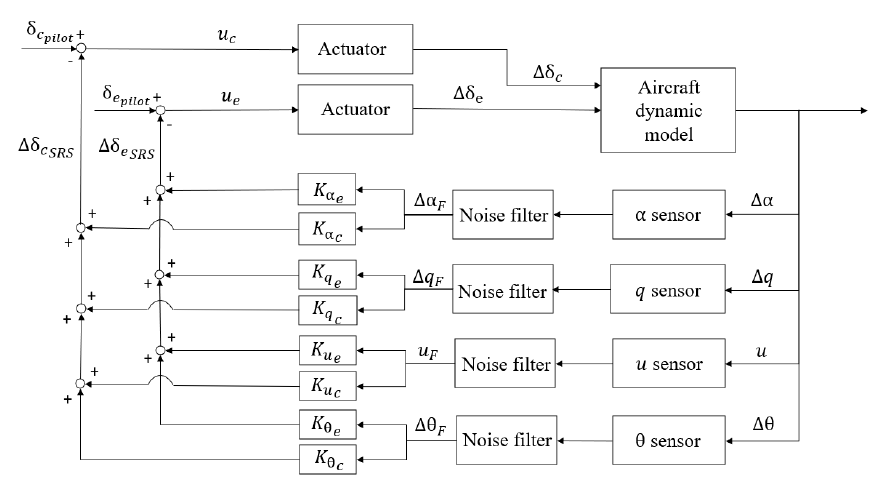
Figure 6. Scheme A for dynamics reassignment of a three-surface